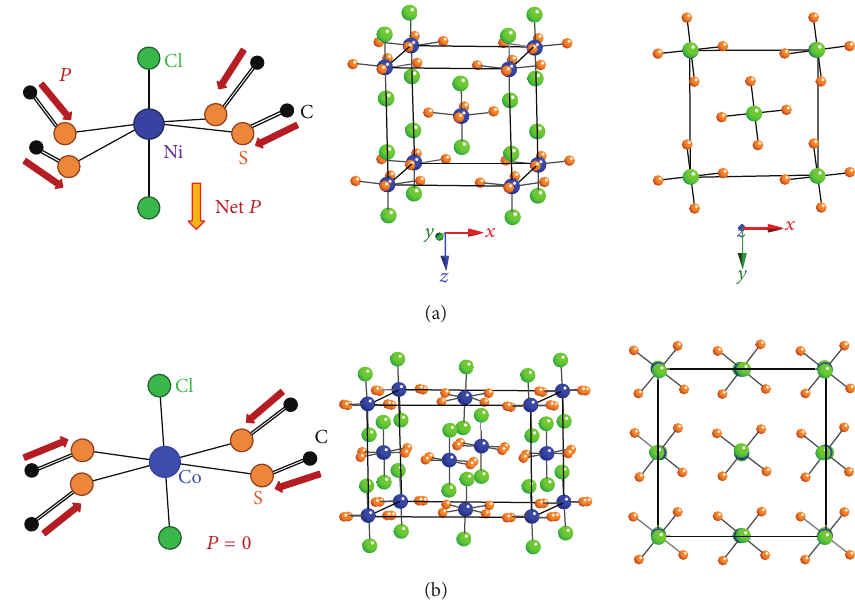
Figure 1: Crystal structure of (a) NiCl 2 -4SC(NH 2 ) 2 (DTN) and (b) CoCl 2 -4SC(NH 2 ) 2 (DTC) with some atoms omitted for clarity. The cartoons on the left show the direction of the electric polarization produced by the S=C bonds.